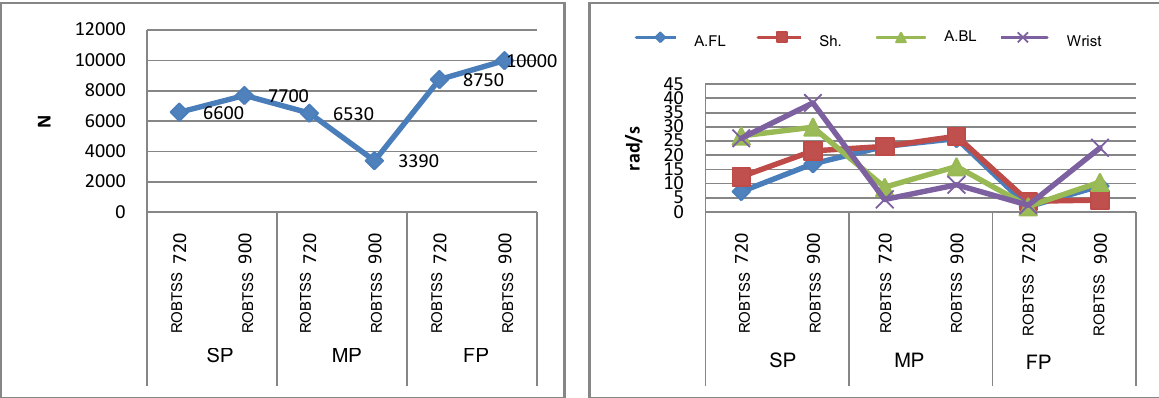
Fig.3. Comparative indicators of resulting GMC force, angle speed of body links of 12-14 years old female gymnasts in dismounts from BB of somersault from RO –backward turnover type. Legend: see tables 1, 2,